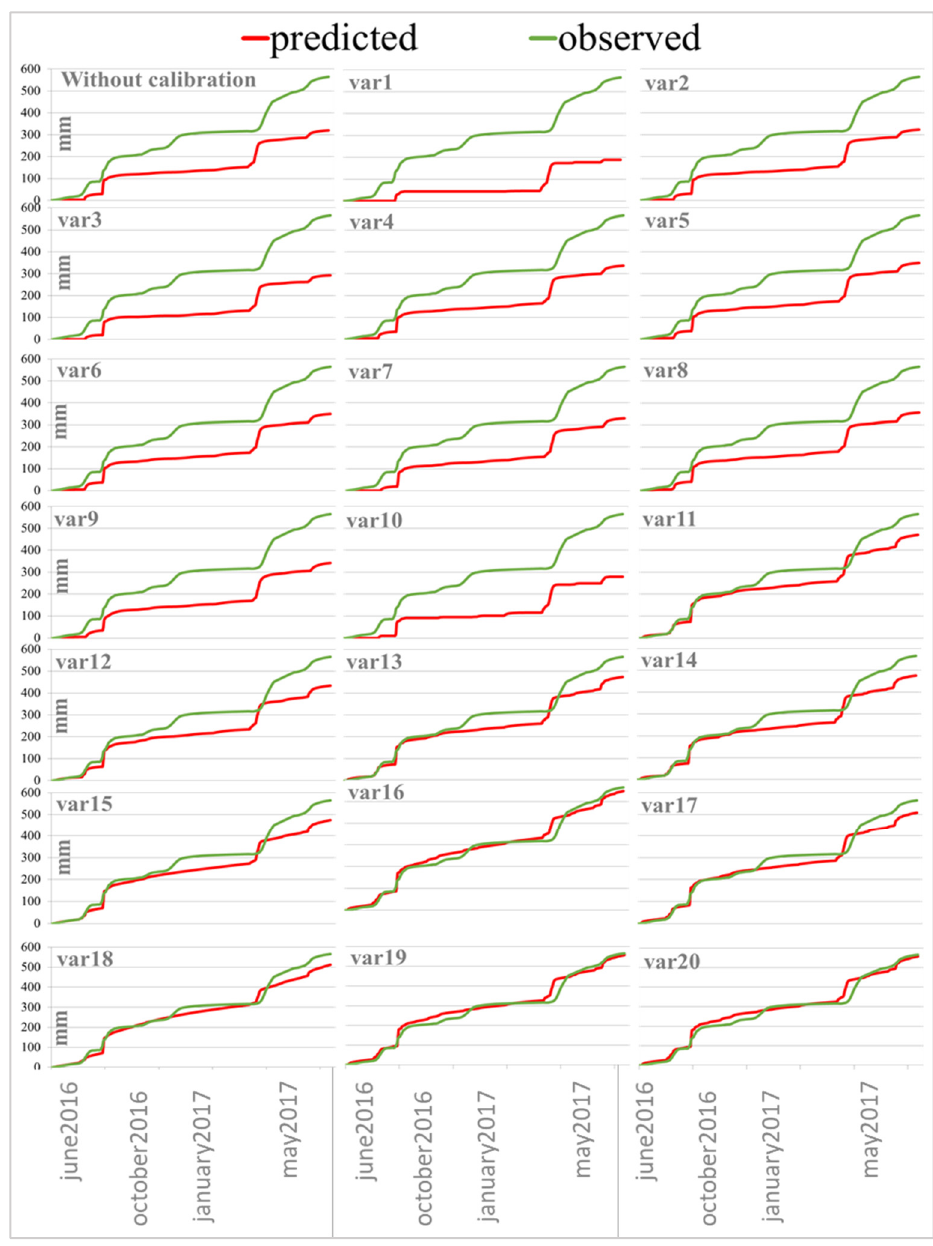
Figure 2. Comparison of experimental (observe) and predicted percolation without/with model calibration (20 options according to Table 3).